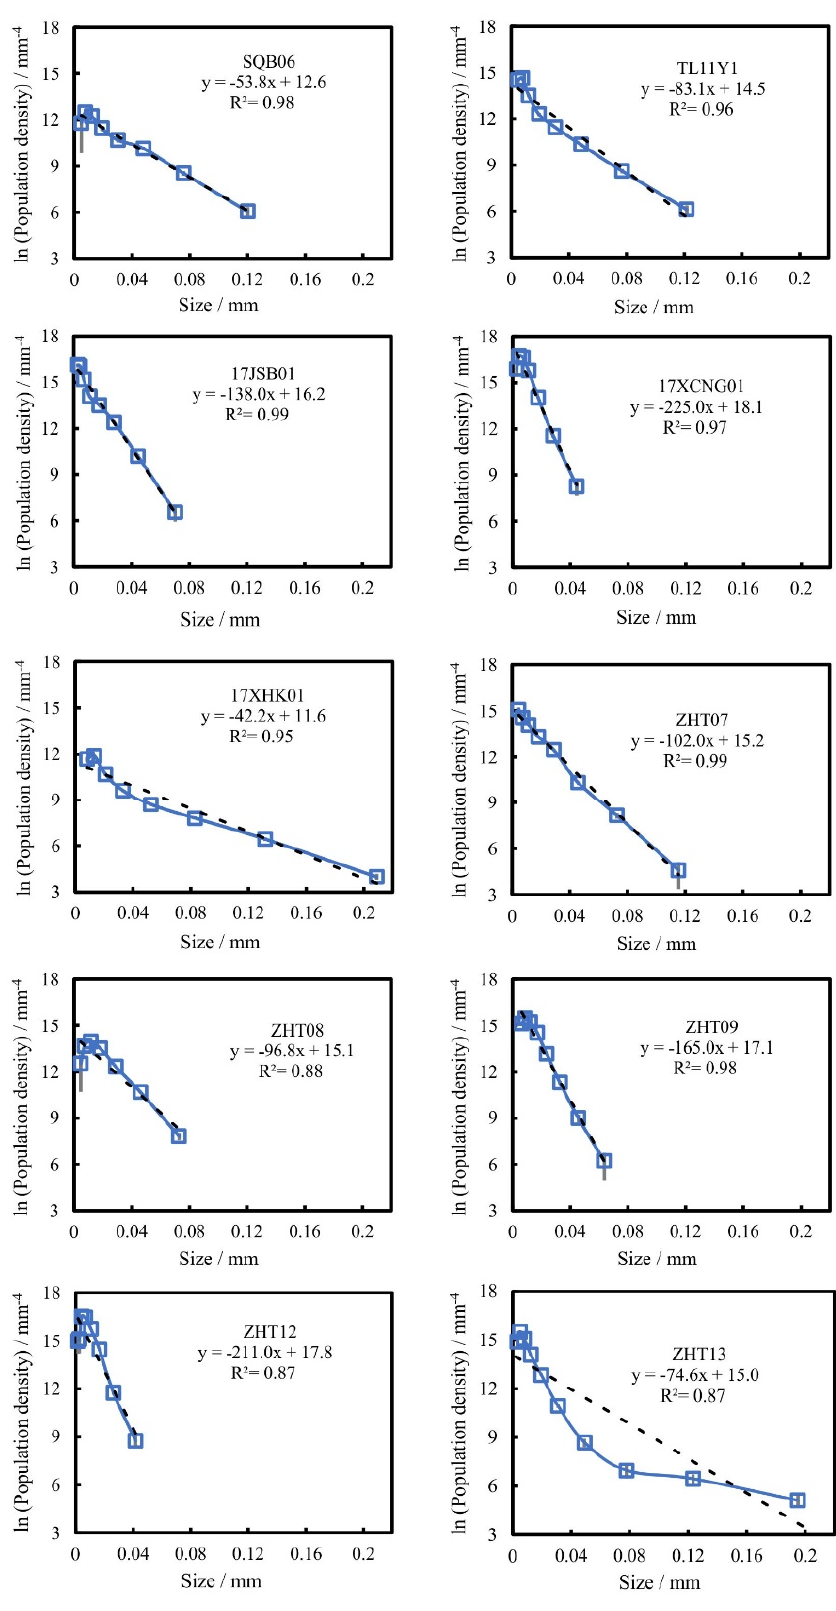
Figure 5. Titanomagnetite crystal size distribution for all the studied Hannuoba alkaline basalt samples. The black dashed lines are the regressions of all data. A shallower slope represents a larger size range and a coarser-grained sample.